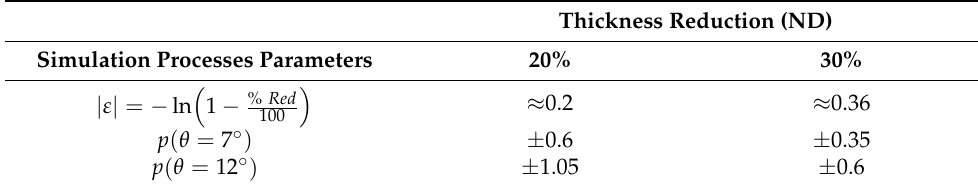
Table 4. Rolling test parameters for the VPSC model.